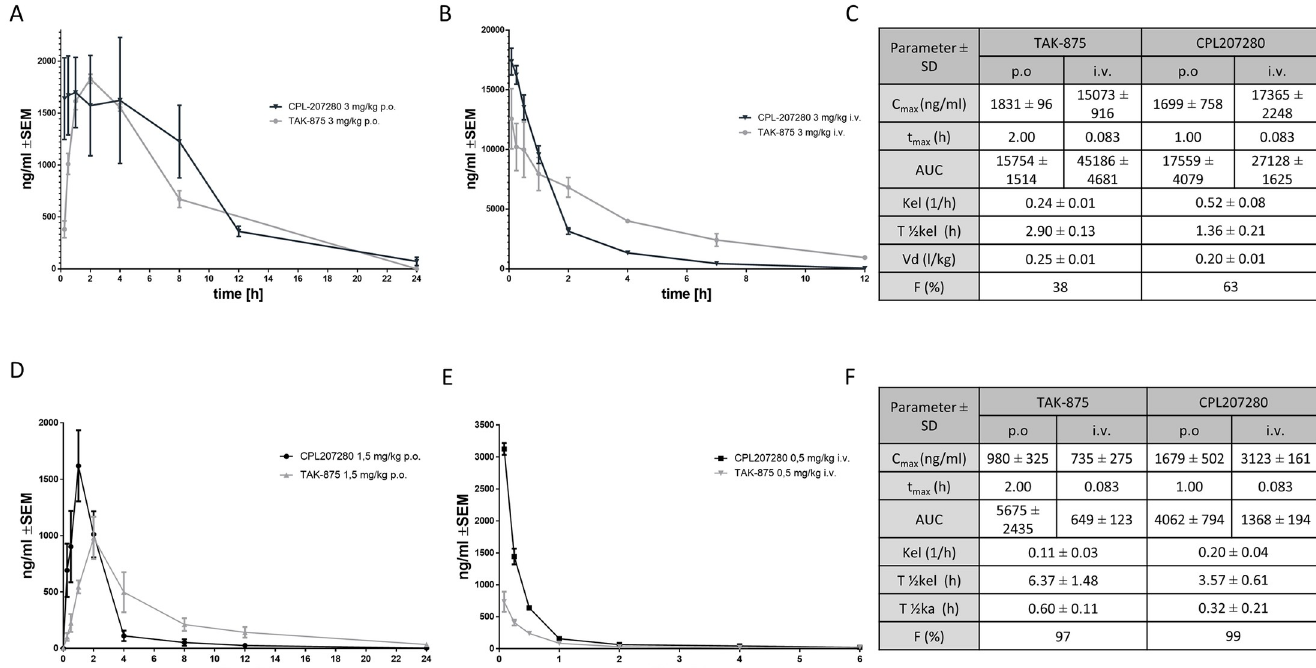
PLOS ONE | https://doi.org/10.1371/journal.pone.0257477 September 23,